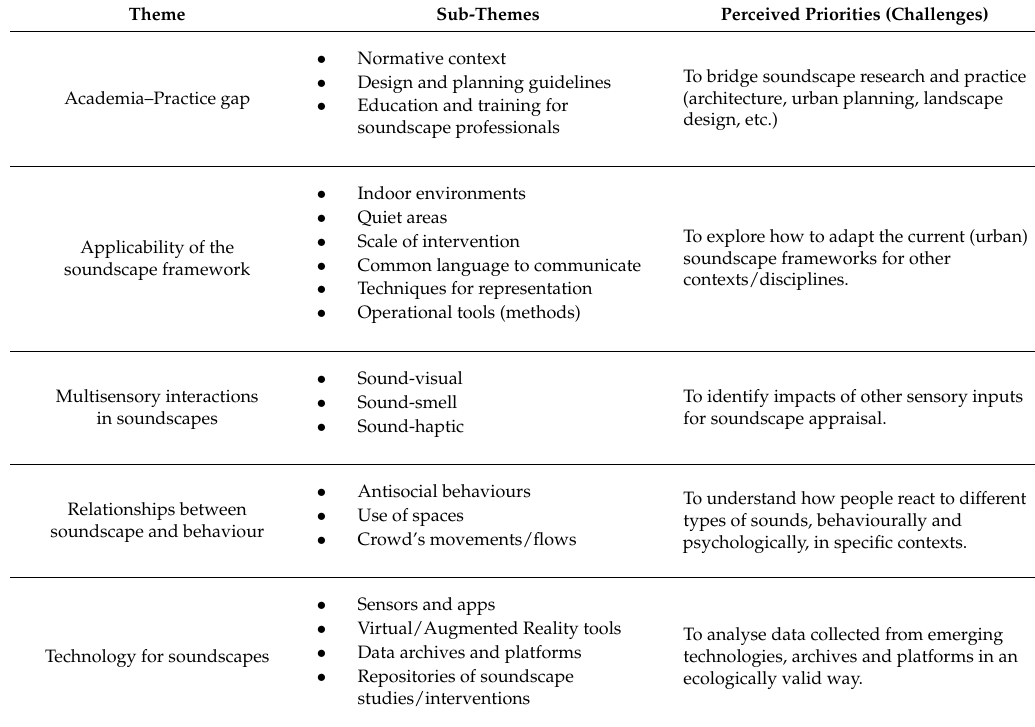
Table 1. Themes identified in the statements of the ten interviewees.